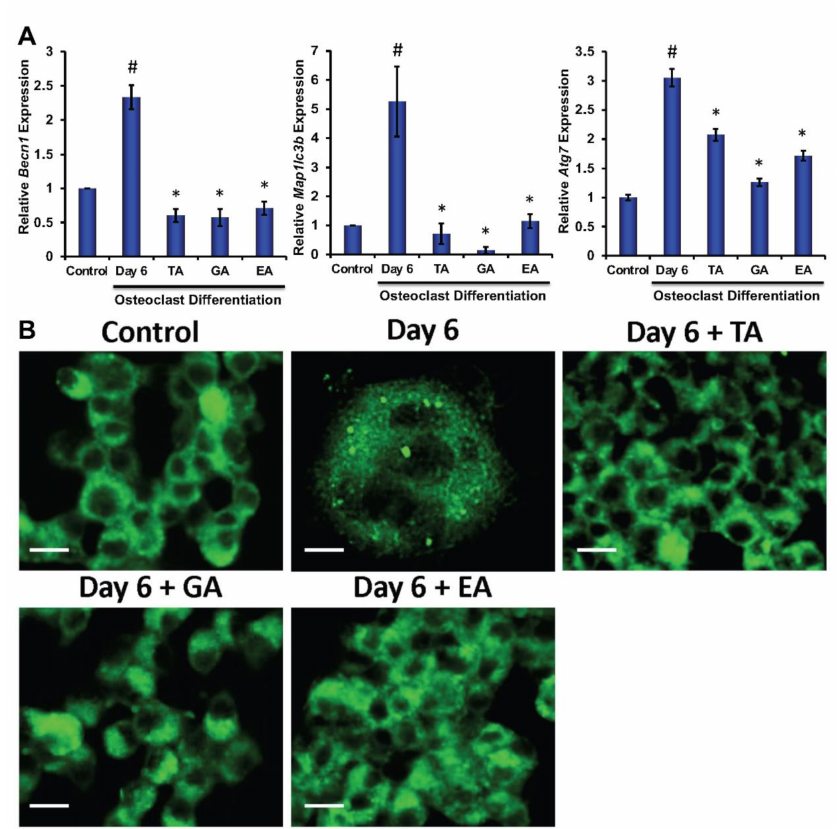
Figure 3. Polyphenolic compounds reduce autophagic gene expressions and autophagic vesicle formations. ( A ). The quantitative real-time PCR analysis of autophagy-related marker genes such as Beclin1 ( Becn1 ), LC3B ( map1lcb ), and ATG7 ( Atg7 ) was shown graphically at day 6 in the absence or presence of tannic acid (TA), gallic acid (GA), or ellagic acid (EA) during osteoclast differentiation. (# indicates p < 0.05 when compared between control and day 6 of osteoclast differentiated samples, * indicates p < 0.05, when compared between day 6 of osteoclast differentiated samples in the absence or presence of either of the polyphenolic compounds) ( B ). Images of the stained autophagic vesi- cles were shown after osteoclast differentiation in cells in the presence or absence of polyphenolic compounds during differentiation. Control indicates undifferentiated cells (Scale bar = 20 µ